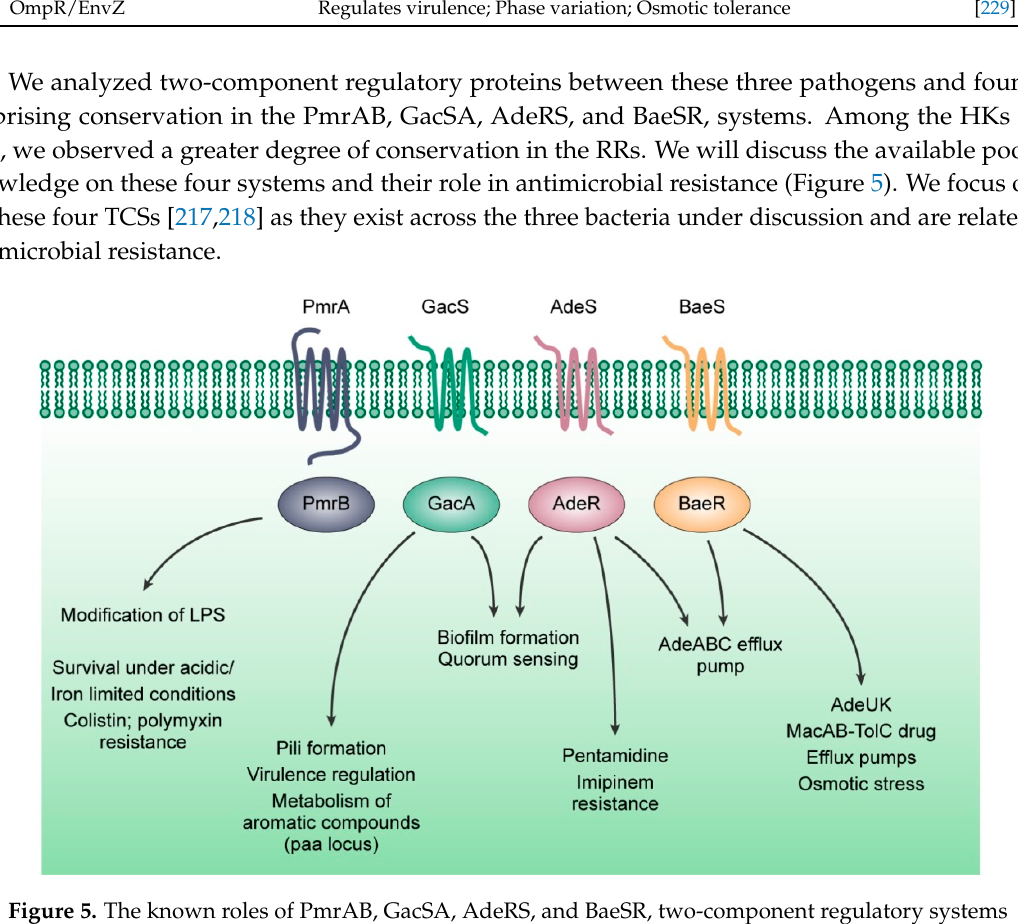
Figure 5. The known roles of PmrAB, GacSA, AdeRS, and BaeSR, two-component regulatory systems in antimicrobial in antimicrobial resistance.